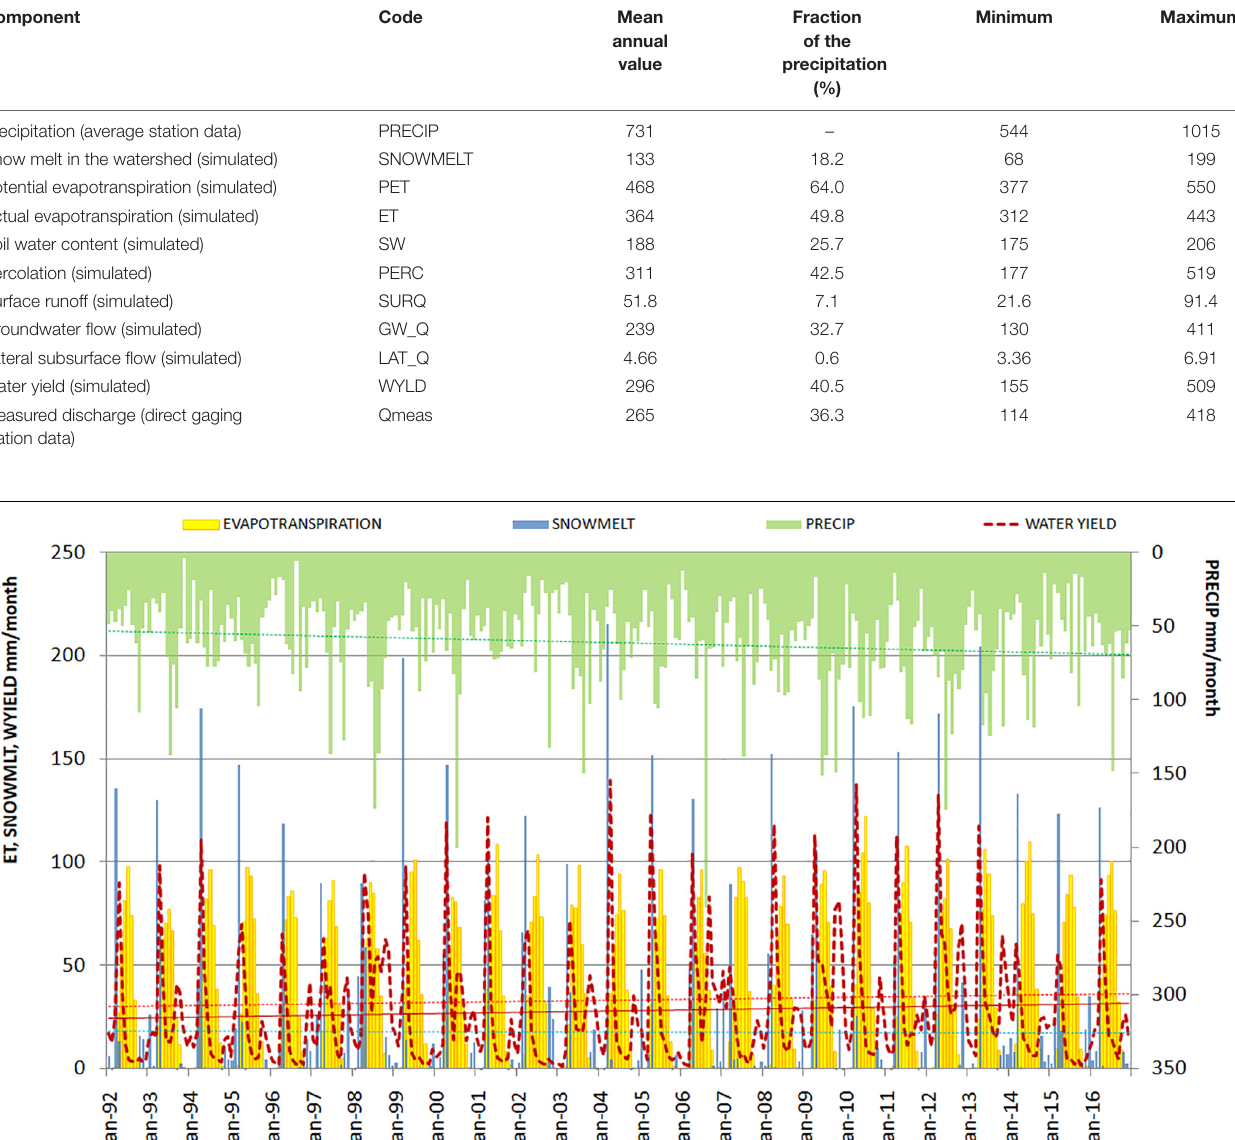
TABLE 7 | Simulated annual water balance components for the period 1992–2016 (values of annual sums in mm) and the fraction of the annual sum of precipitation (%). Component Code